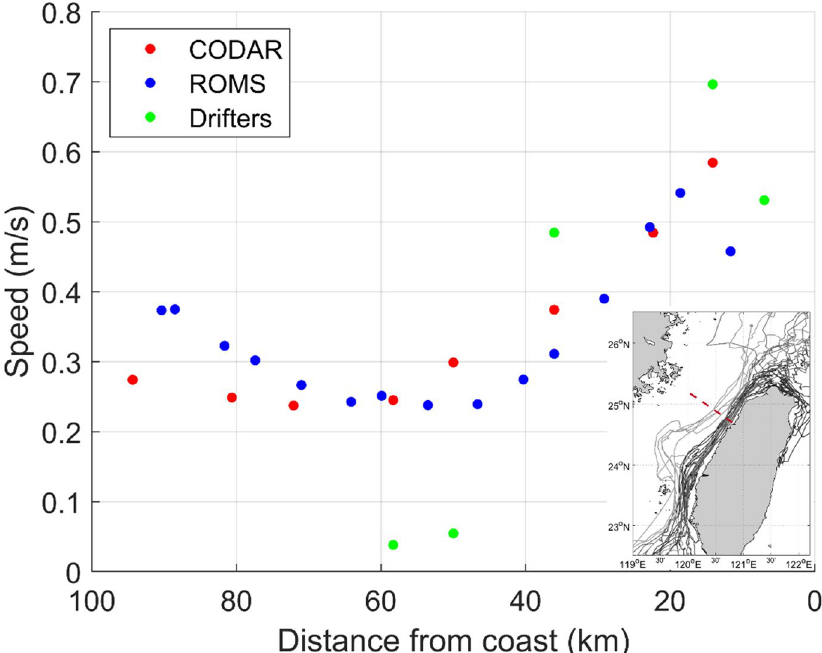
Figure 12. Average alongshore speeds of the cross-shore distributions from three datasets during summer. The red dotted line represents the transect for the cross-shore distribution.